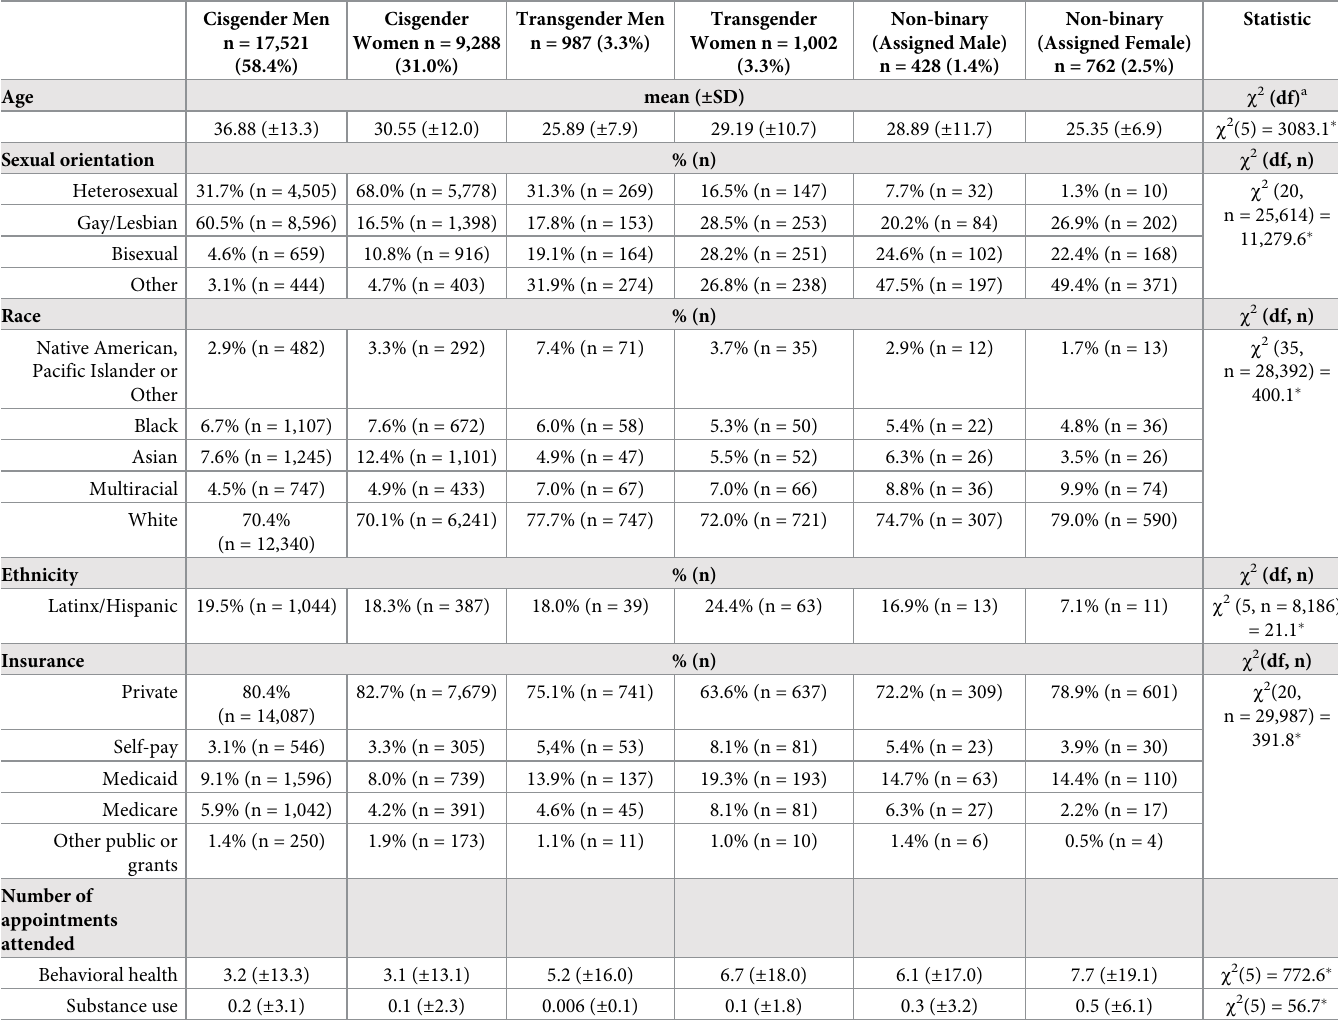
Table 2. Sociodemographic characteristics and number of behavioral health/substance use appointments attended by sex and gender category (N =